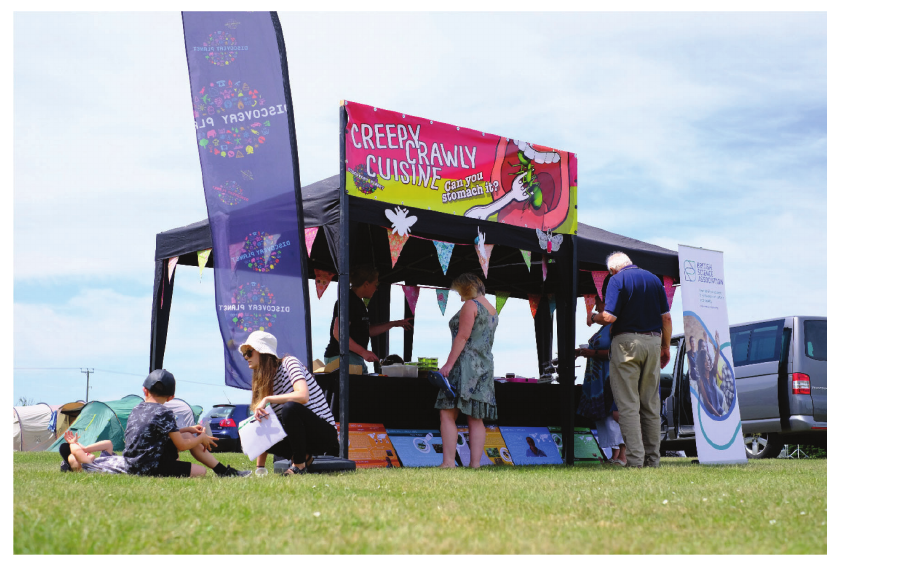
Figure 3: Participants at the campsite science